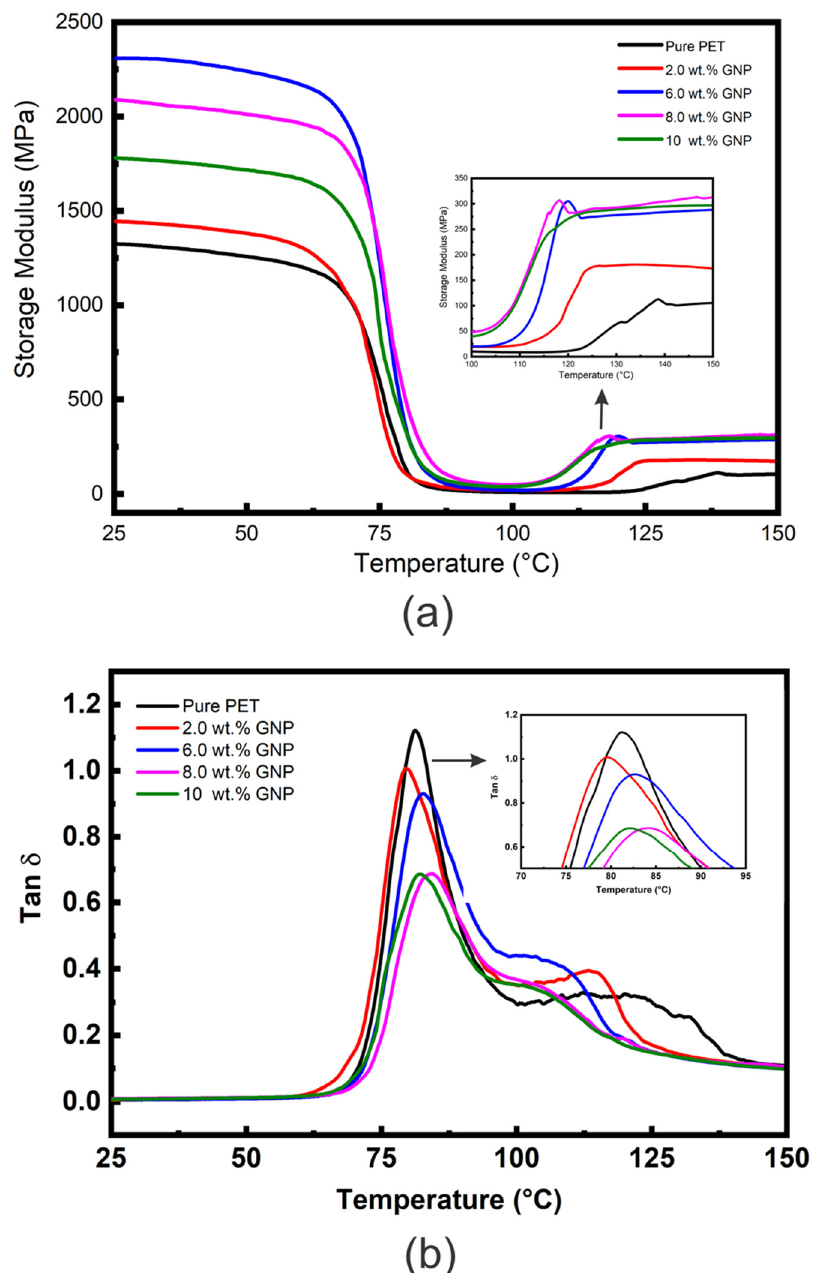
Figure 4. ( a ) DMTA E’ vs. temperature data and ( b ) DMTA tan δ vs. temperature data for the PET/GNP nanocomposites. Table 2. Selected DMTA data for E (cid:48) , T g and tan δ of PET/GNP nanocomposites. GNP (wt.